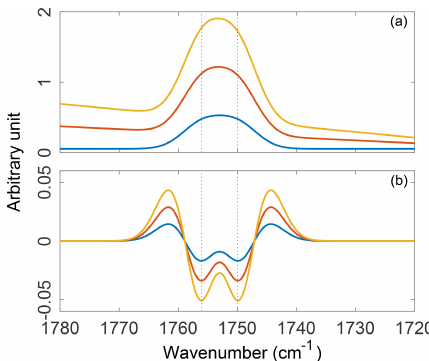
Figure 7. Three synthetic absorption spectra constructed with vary- ing contributions from a polynomial baseline and two unresolved Gaussian peaks (a) and their second-order, five-point, second- derivative Savitzky–Golay filter transformations (b) . Absorption spectra were constructed such that the additive, linear, and poly- nomial components of the baseline scale with the amplitude of the absorption